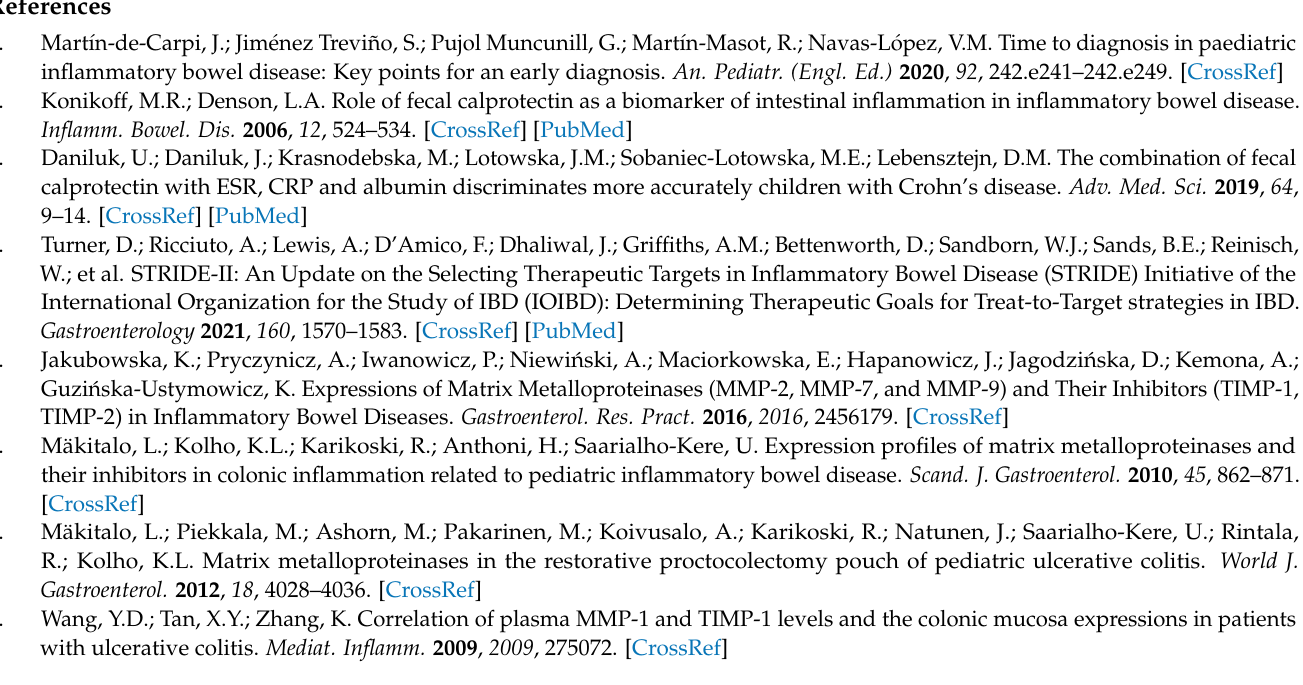
Figure S1: Immunohistochemical staining showing mucosal expression of TIMP-1 and MMP-9 in UC and Control